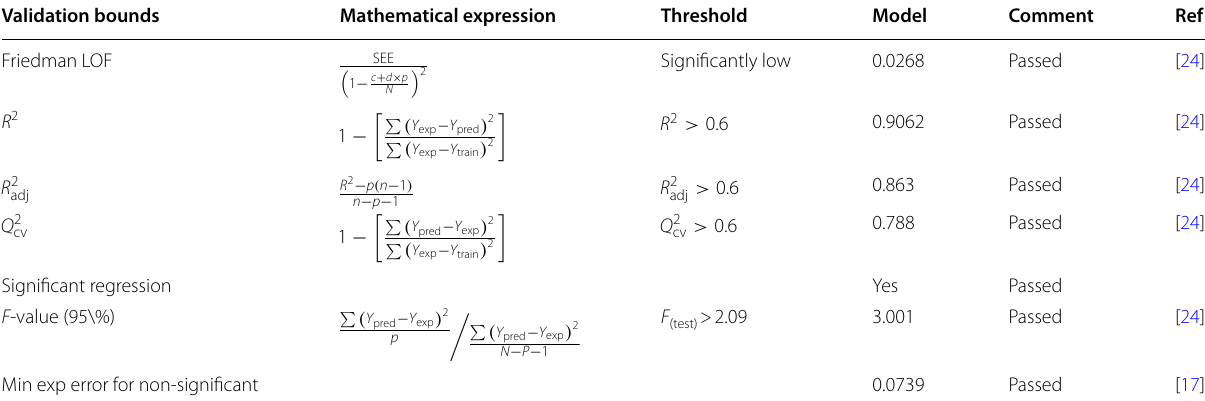
Table 5 Validation parameters to confirm the built model